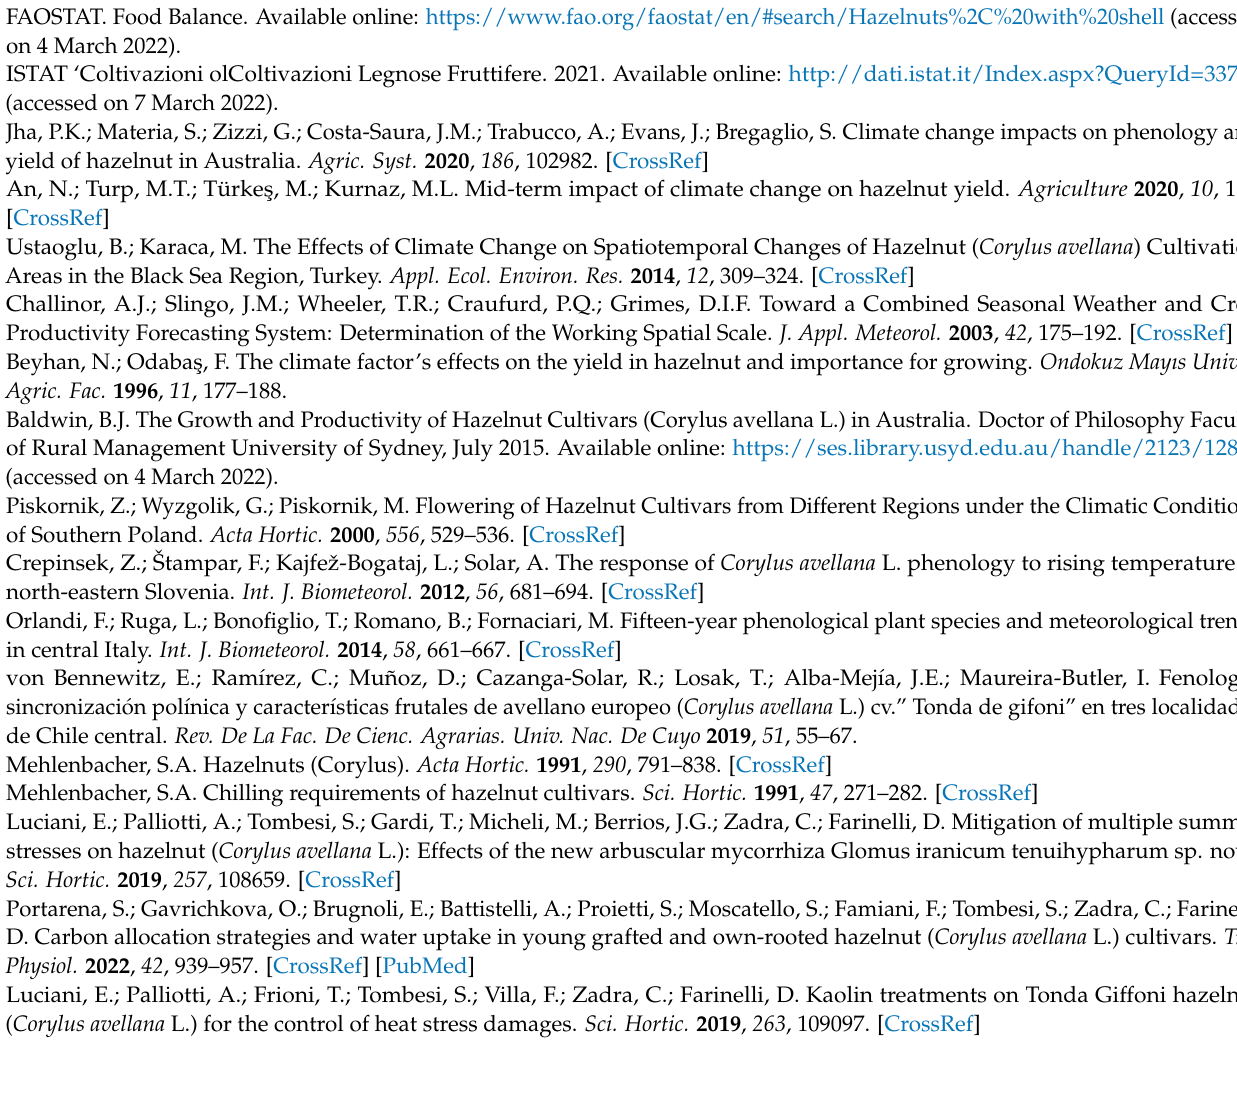
while the upward arrows denote increasing trends. Full arrows indicate significant trends with p < 0.05, while empty arrows indicate no significance. The red arrows represent a trend of decrease in rain, while the blue arrows represent a trend of increase in rain. The altitude classes are given on the upper right. Figure S9: Trend in chilling hours accumulated in Chieti (CN 5) from 1980 to 2019. Orange circles represent the value of CU each year. Figure S10: Trend in growing degree days at Vasto (CN 2) from 1980 to 2019. Blue circles represent the value of GDD each year. Table S1: Annual maximum temperatures (T. max), monthly maximum temperatures (40-year averages), and coefficient of variation per station and month.; Table S2: Annual minimum temperatures (T. min), monthly minimum temperatures (40-year averages), and coefficient of variation per station and